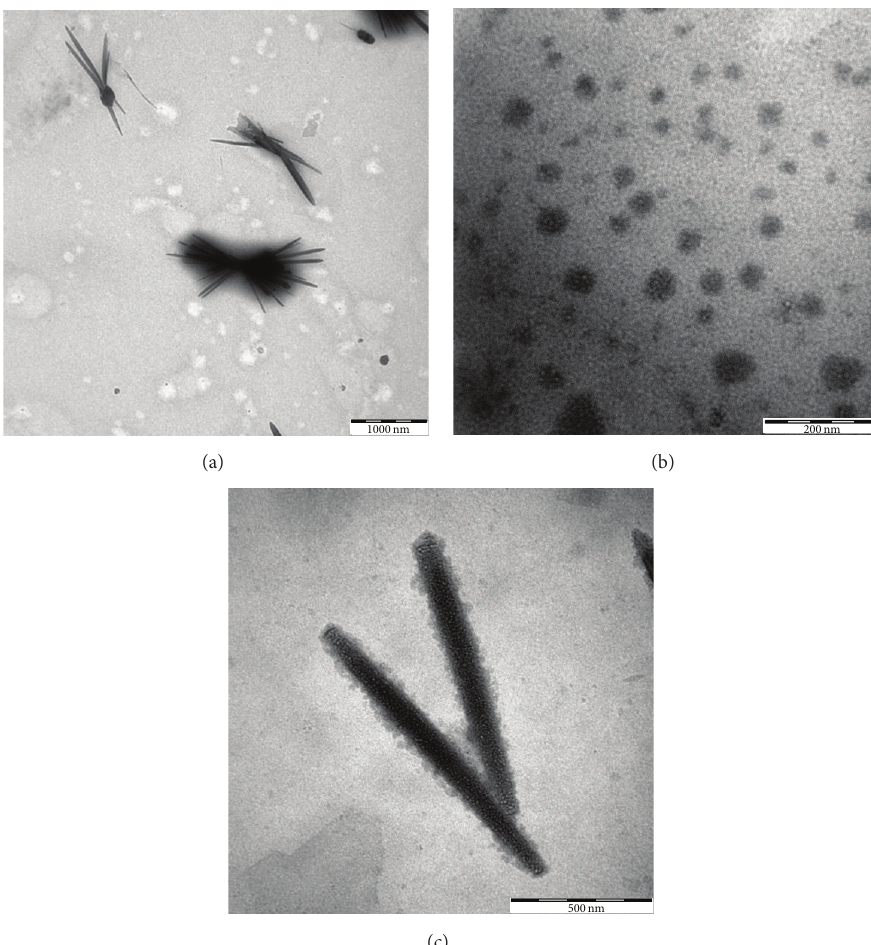
Figure 1: TEM micrograph of (a) ZnO nanowhiskers, (b) NiO nanoparticles, and (c) NiO-ZnO